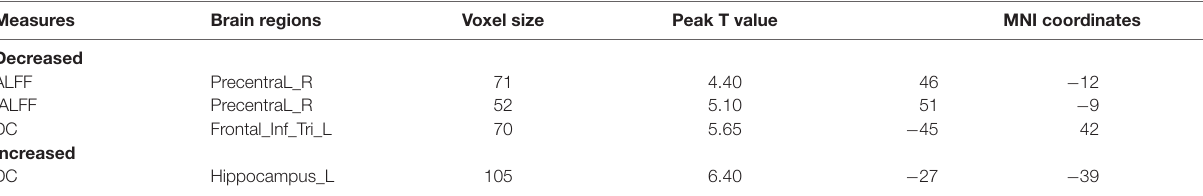
TABLE 2 | Significant differences in ALFF, fALFF, and DC between depression adolescents